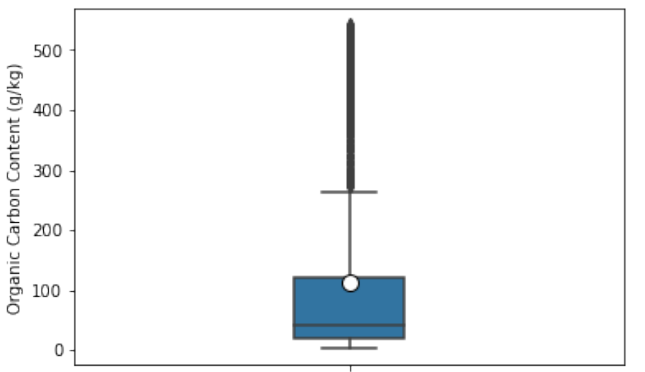
Figure 5. Box-plot of soil organic carbon interquartile range, mean, skewness, and outliers.